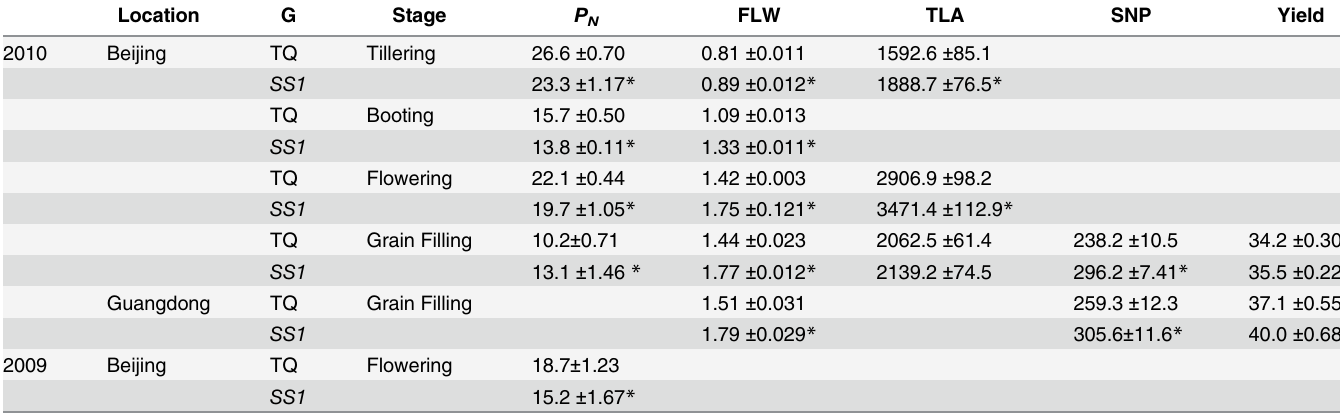
Table 1. The photosynthetic rate ( P N , μ mol (cid:129) m − 2 s − 1 ), flag leaf width (FLW, cm), total leaf area (TLA, cm 2 (cid:129) plant − 1 ), in the leaves of Teqing (TQ) and NIL- SS1 ( SS1 ) at different growth stages and the spikelet number per panicle (SNP), grain yield (g (cid:129) plant − 1 ) in 2009 and/or 2010.